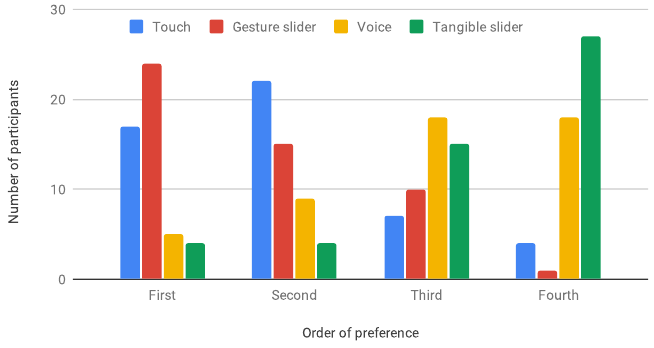
Figure 9. Page content navigation technique preference results from the second user